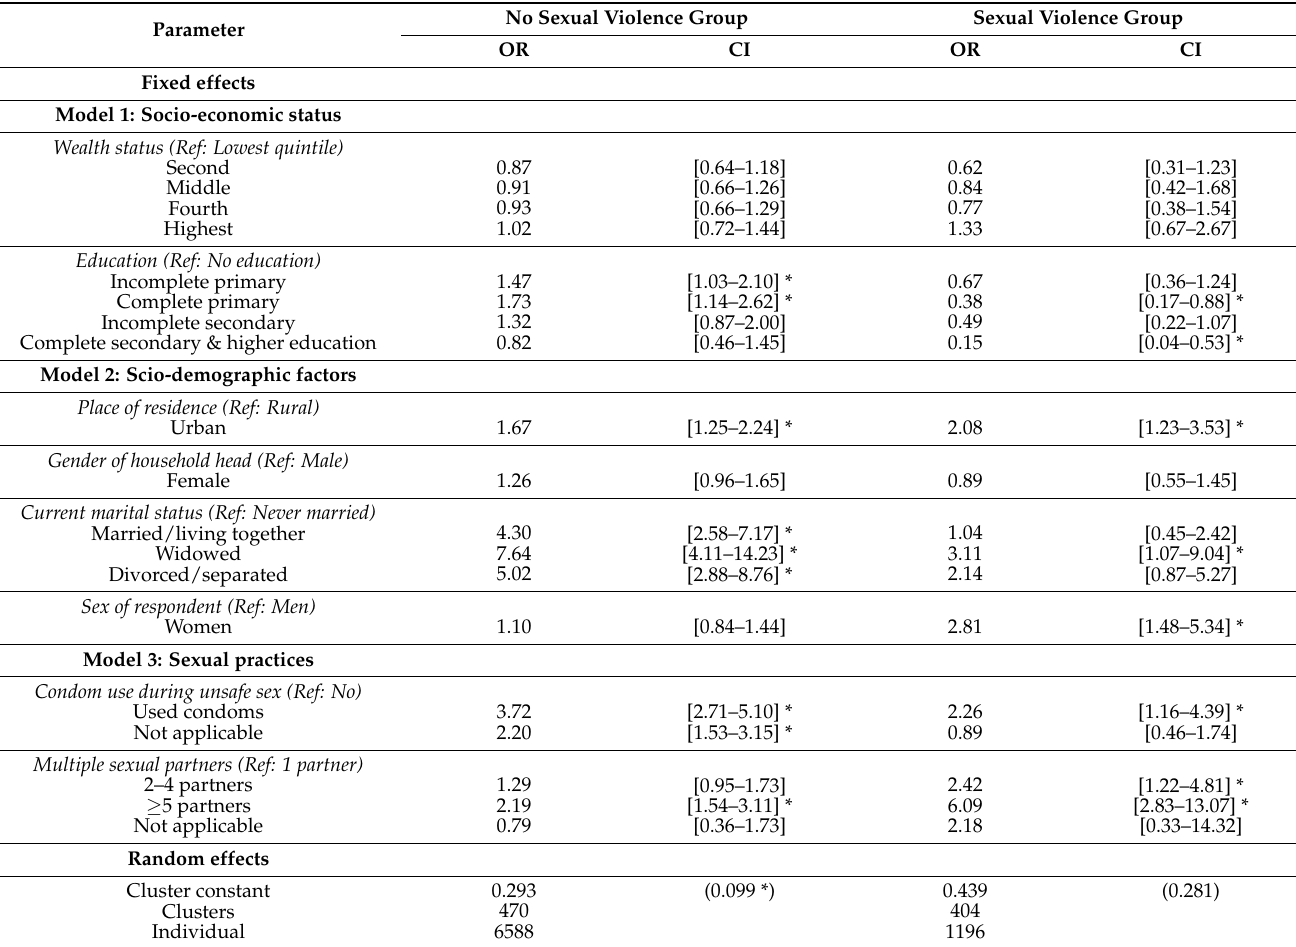
Table 5. Comparative analysis of HIV prevalence between victims and non-victims of sexual violence, UAIS, 2011 ( n = 1196, victims; and n = 6588, non-victims). No Sexual Violence Group Sexual Violence Group Parameter OR CI